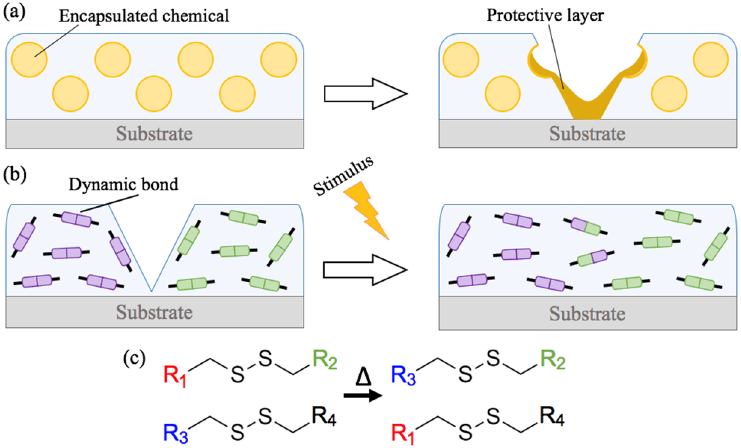
Figure 1. Illustration of ( a ) extrinsic and ( b ) intrinsic strategies to obtain self-healing coatings and ( c ) disulfide metathesis reaction.